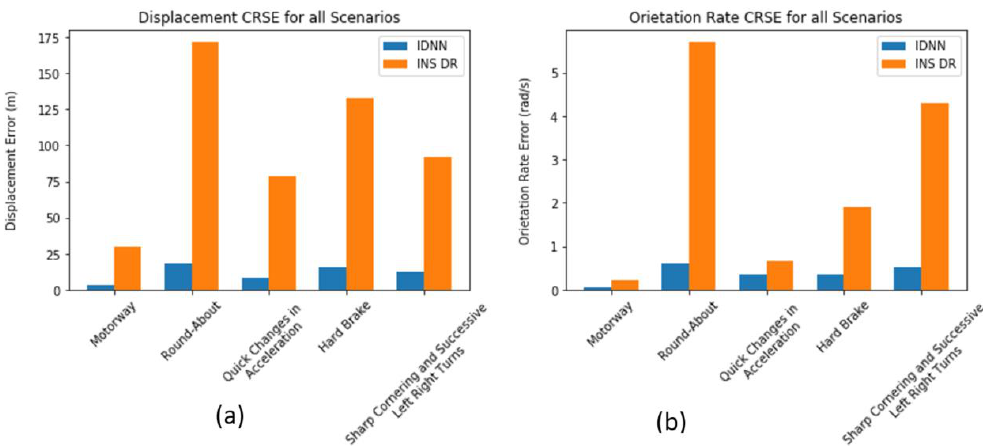
Figure 7. Showing the comparison of the CRSE performance of the IDNN and INS DR across all investigated scenarios on the ( a ) displacement estimation and ( b ) orientation rate